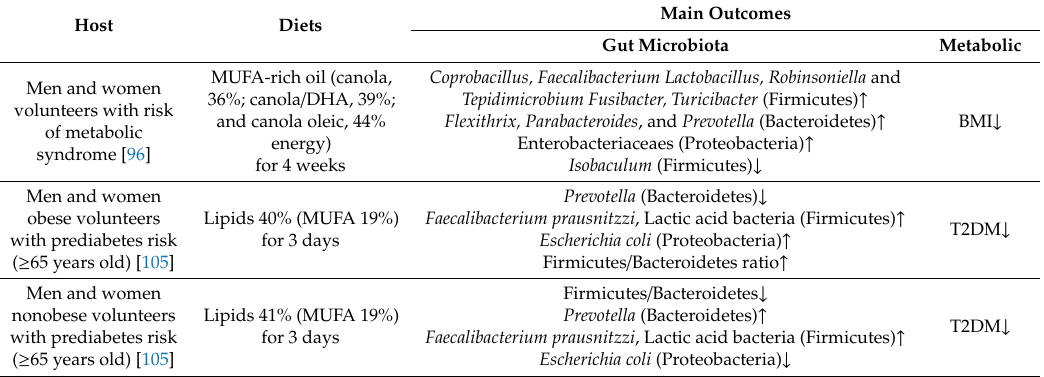
Table 4. E ff ects of monounsaturated fatty acids intake on gut microbiota composition and metabolic outcomes in